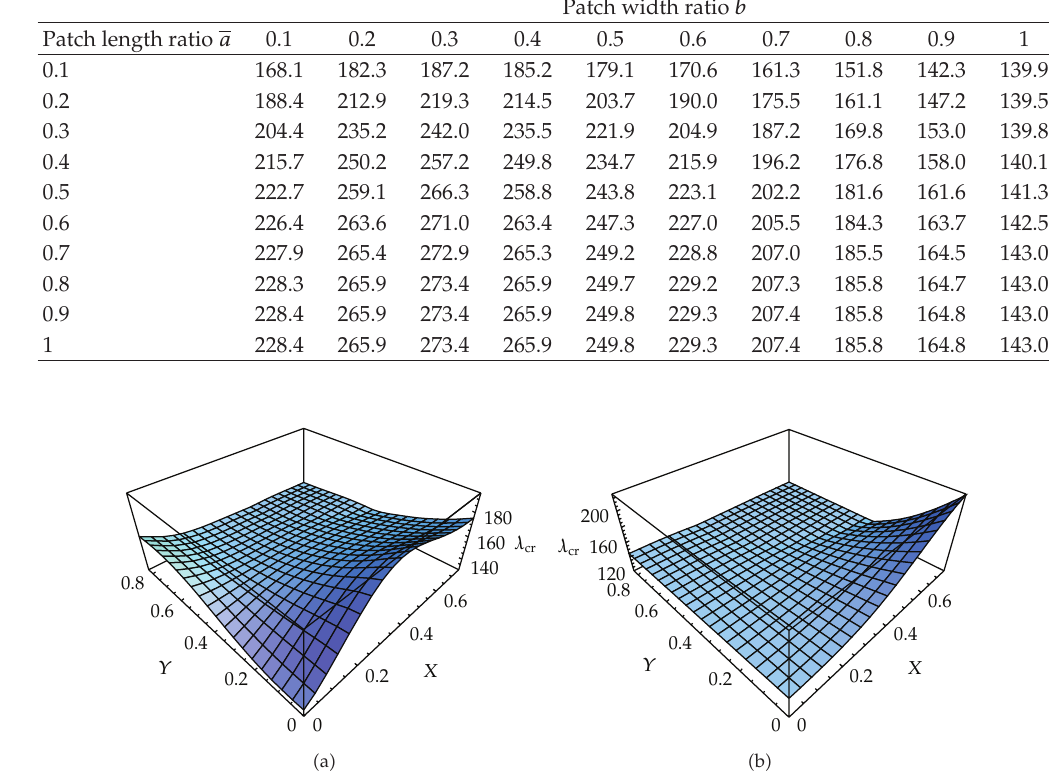
Table 3: Maximum critical dynamic pressure versus dimensional ratios of the bonded patch.